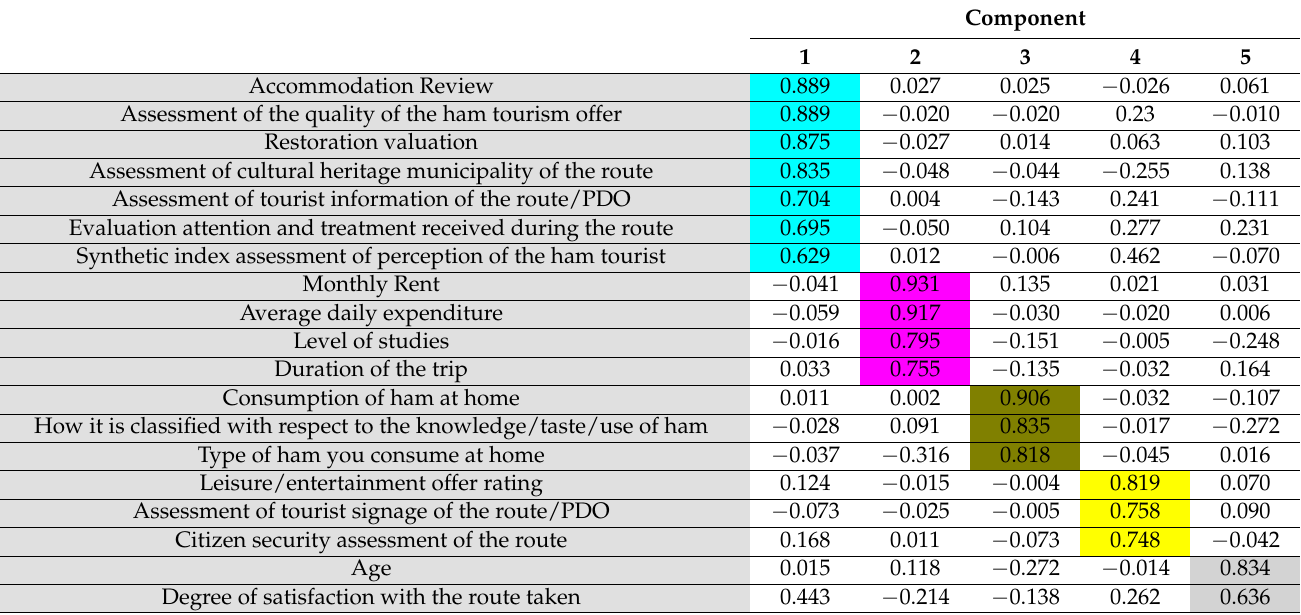
Table 7. Component matrix rotated